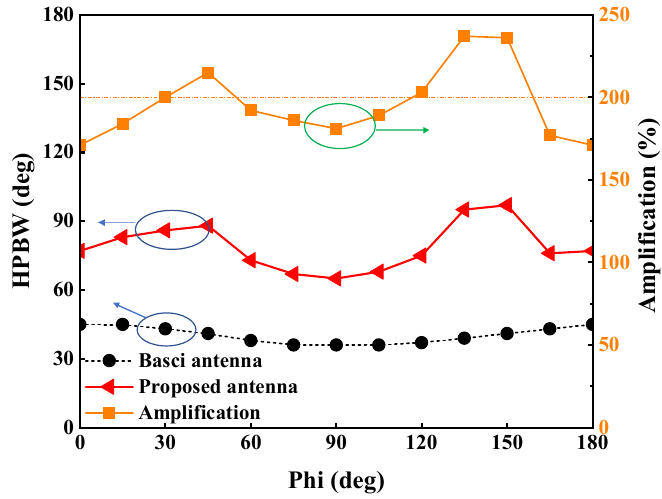
Figure 4. HPBW values of two antennas and their ratios in different cut-planes.